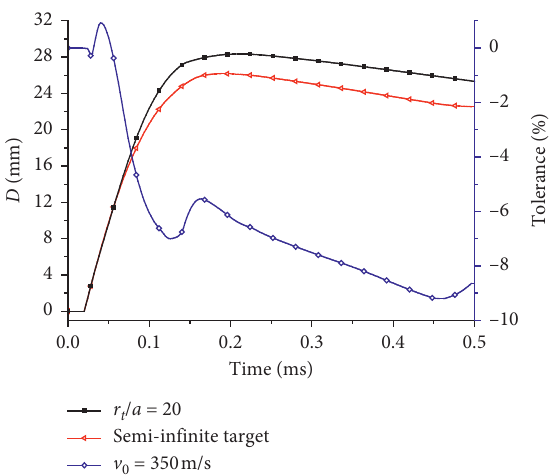
Figure 18: Deviation comparison of the penetration depth for the free boundary ( r t / a � 20) and the nonreflecting boundary ( v � 350m/s).